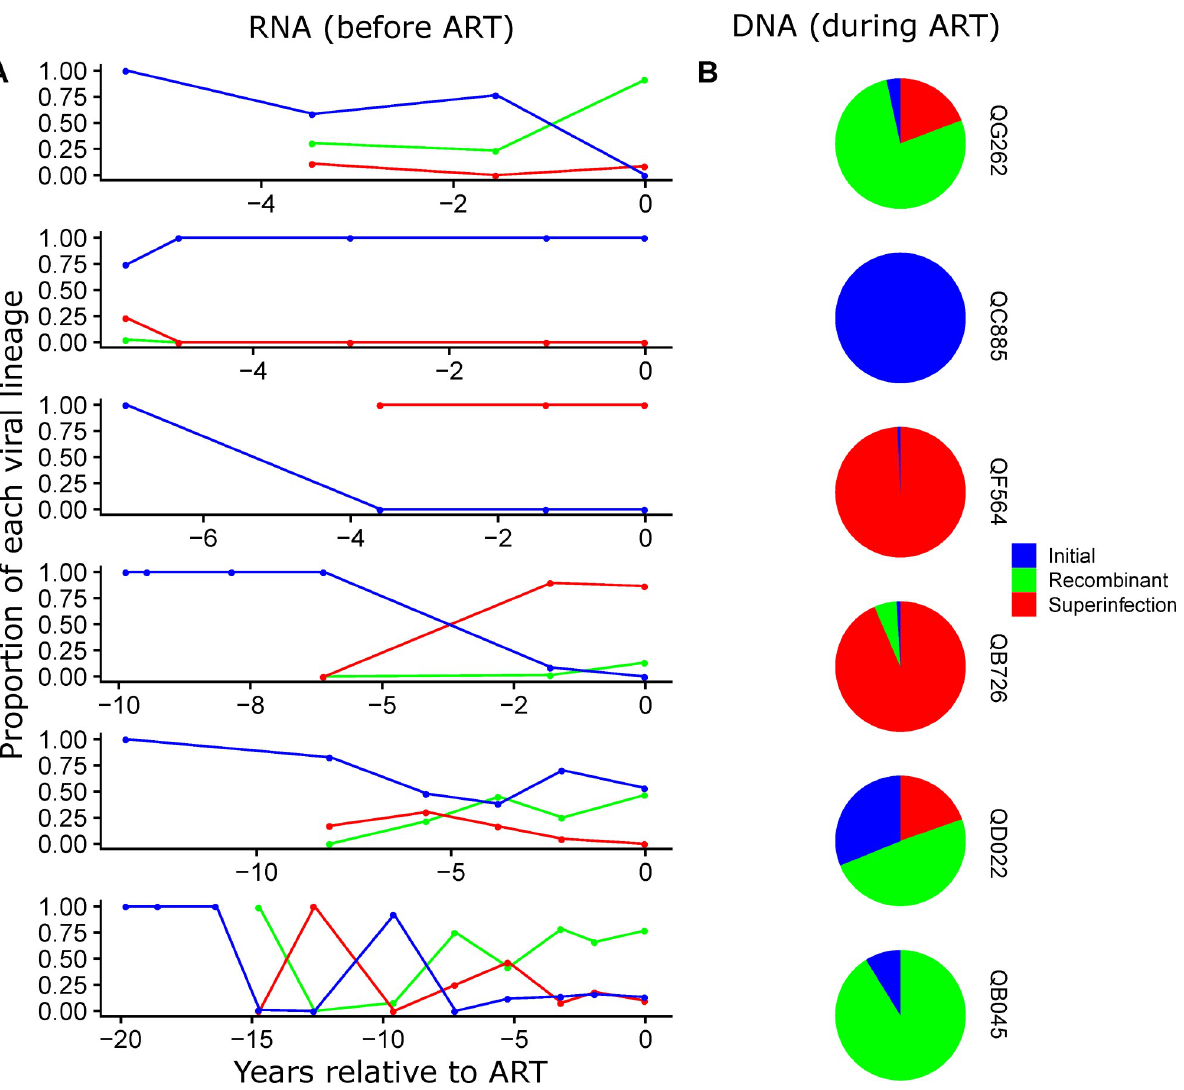
Fig 2. Proportion of gag sequences from initial and superinfecting virus lineages prior to and during suppressive ART. (A) Proportions of initial, superinfecting and recombinant virus sequences in HIV gag RNA from plasma prior to ART. (B) HIV gag DNA from PBMCs collected > 6 months after viral suppression on ART. Blue denotes the initial viral variant, red denotes the superinfecting variant, and green denotes within- gag recombinants.